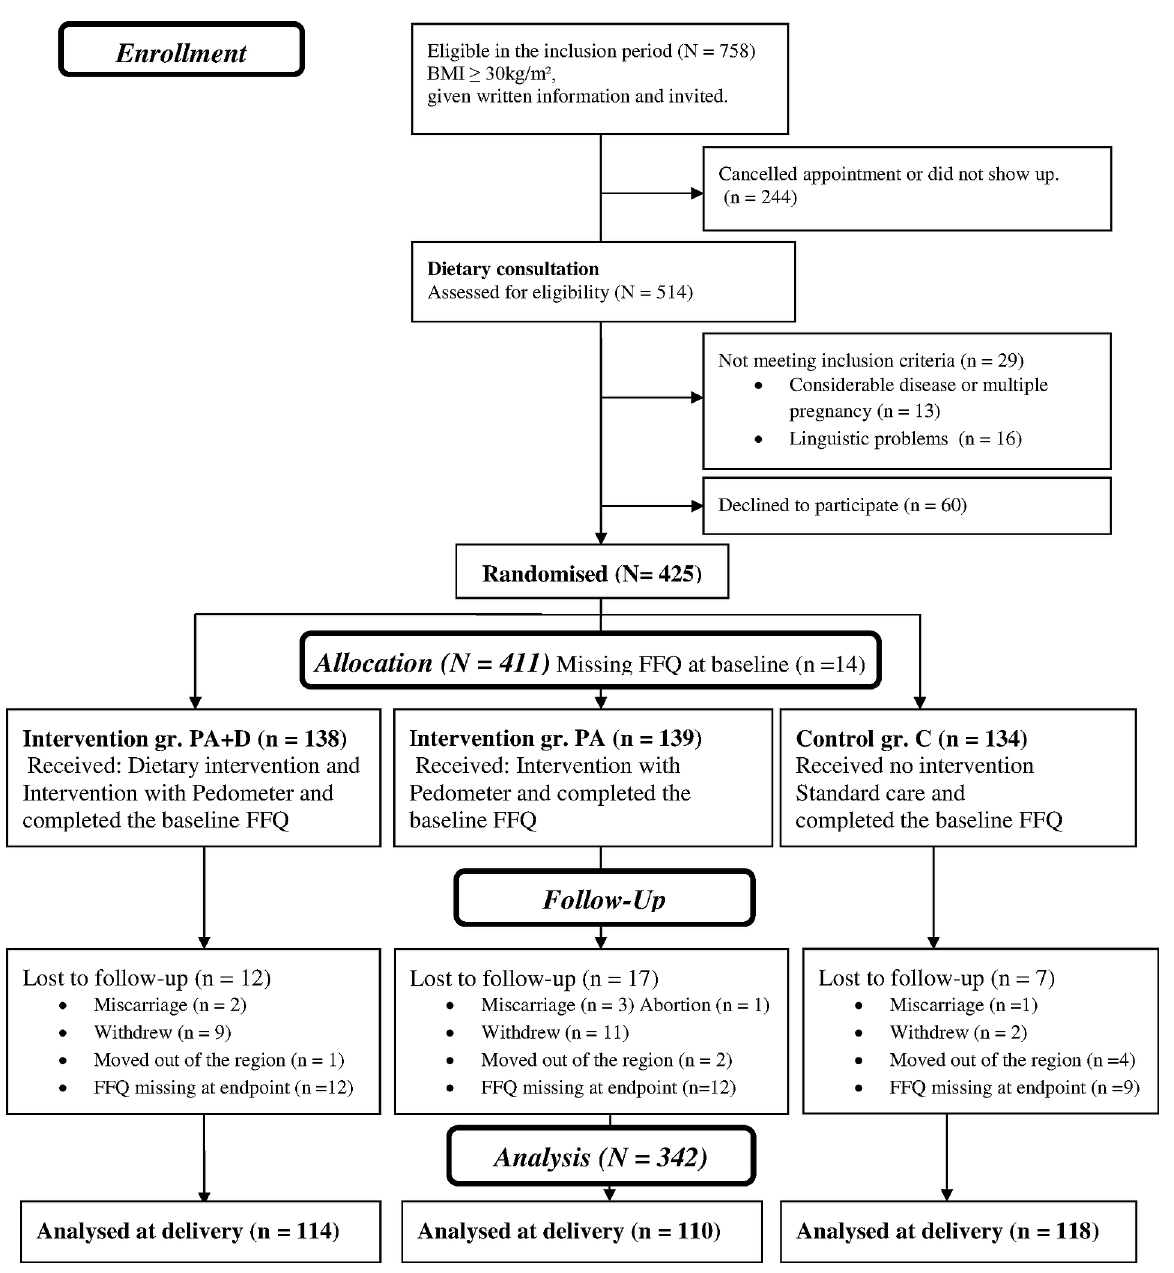
Fig 1. Flow Diagram. The flow diagram describes allocation and inclusion in the TOP-study and in the current